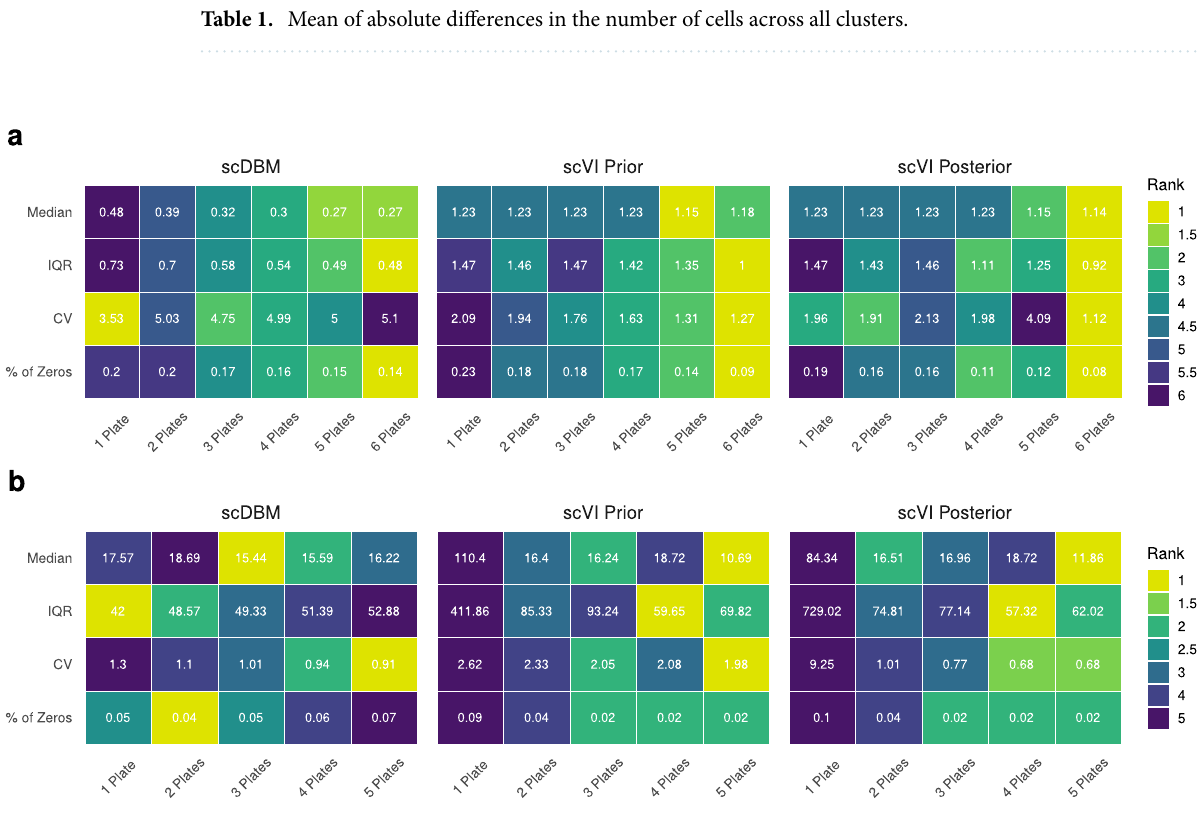
Figure 3. Mean absolute deviation for various descriptive statistics across all models and sample sizes for the PBMC 4 k dataset ( a ) and the Segerstolpe dataset ( b ). Color coding indicates ranks among sample